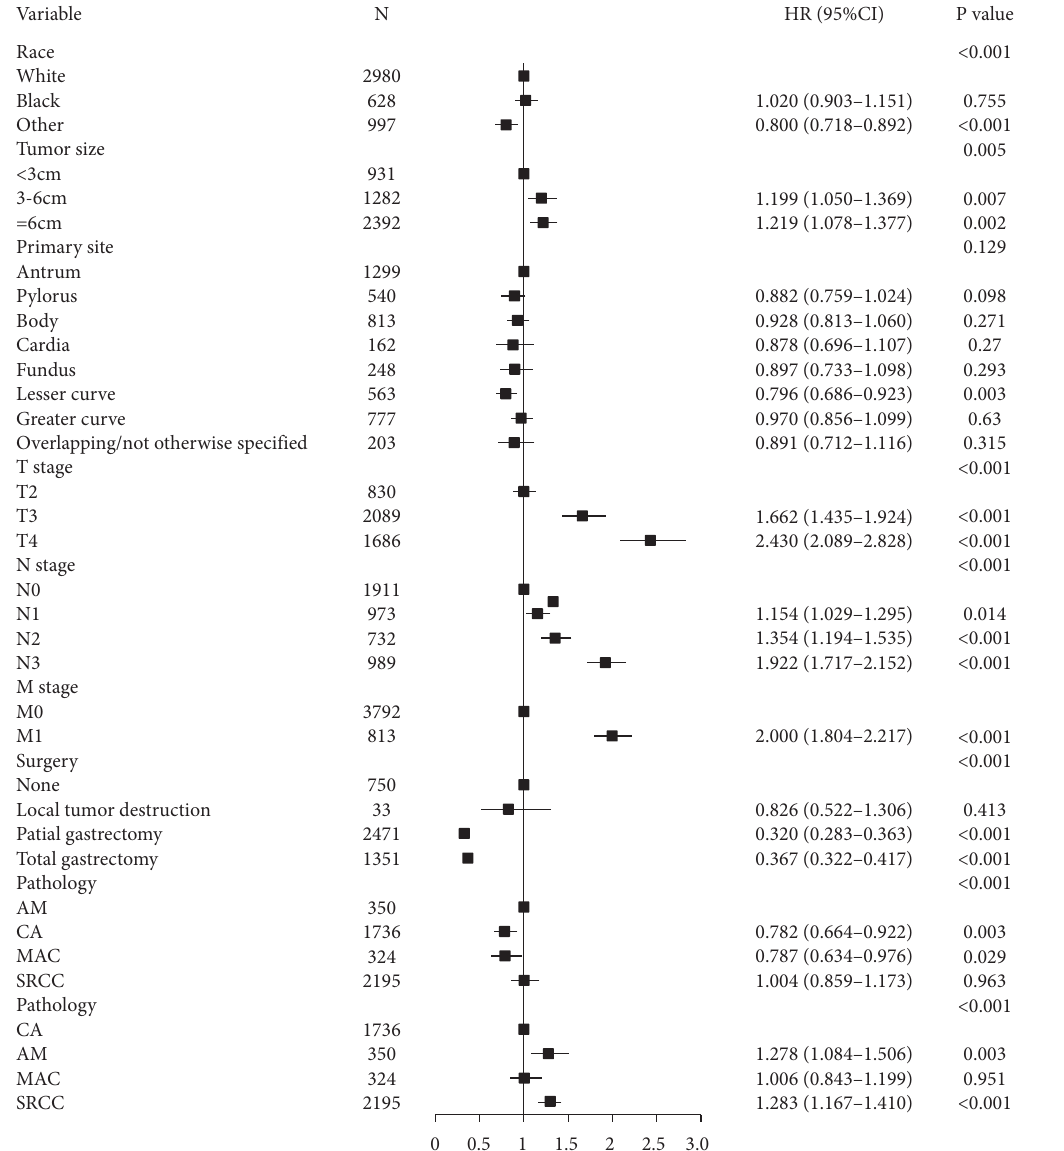
Figure 3: Forest plot showing results of the multivariate Cox regression model for the cancer-specific survival of histologic subtypes in advanced gastric cancer (AGC). Table 5: Results of competing risks regression with inclusion of possible risk factors in patients with early gastric cancer.